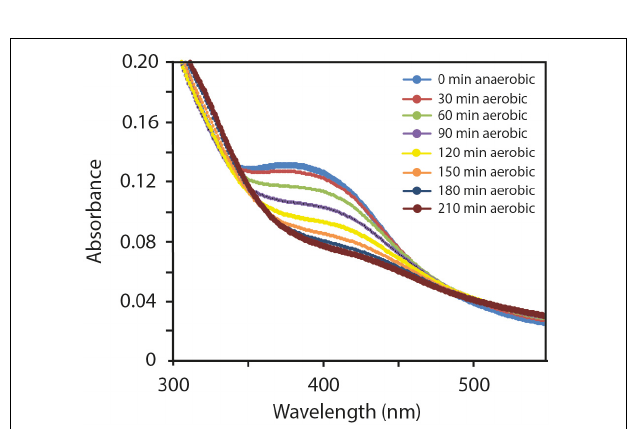
FIGURE 6 | Effect of O 2 exposure on the ultraviolet/visible spectrum of anoxically purified FNR AF (10 µ M). Changes are shown occurring in the 300–550 nm spectral region after 0, 30, 60, 90, 120, 150, 180, and 210 minutes exposure to O 2 .